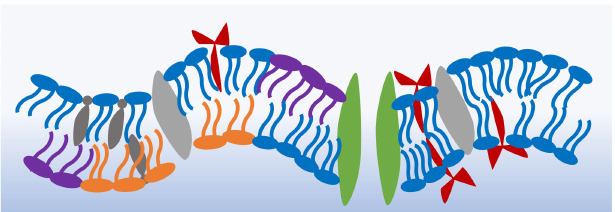
Figure 1. A schematic illustrating the complexity of natural cell membranes. The base structure of these barriers is a double layer of phospholipids. Transport proteins, sterols and other biomolecules are present in different parts of the membrane depending on the cell’s role and life cycle